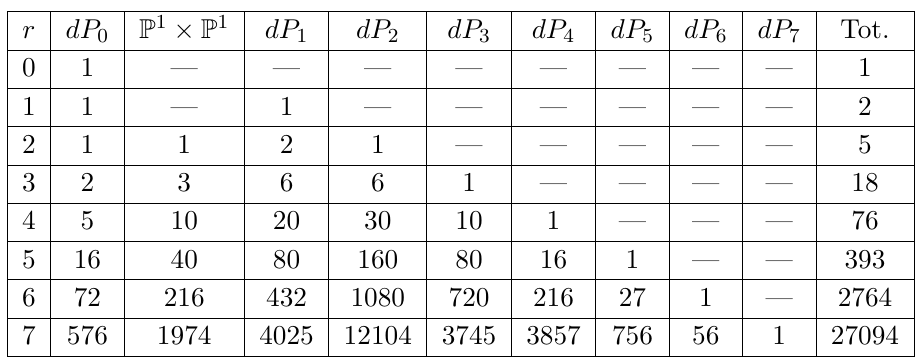
Table 5 . The statistics of di(cid:11)erent blow downs of the dP r surfaces, r = 0 ; (cid:1) (cid:1) (cid:1) ; 7. The numbers in parentheses count the (cid:12)brations up to permutations of the exceptional divisors of the del Pezzo factors.